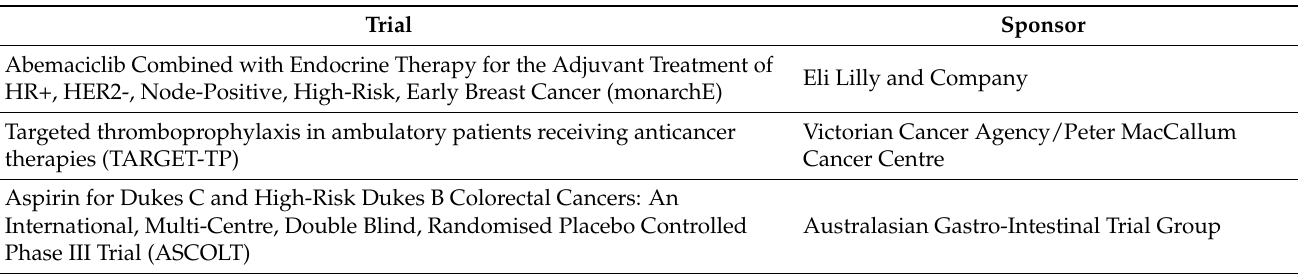
Table 2. Examples of COSA ATM portfolio trial diversity